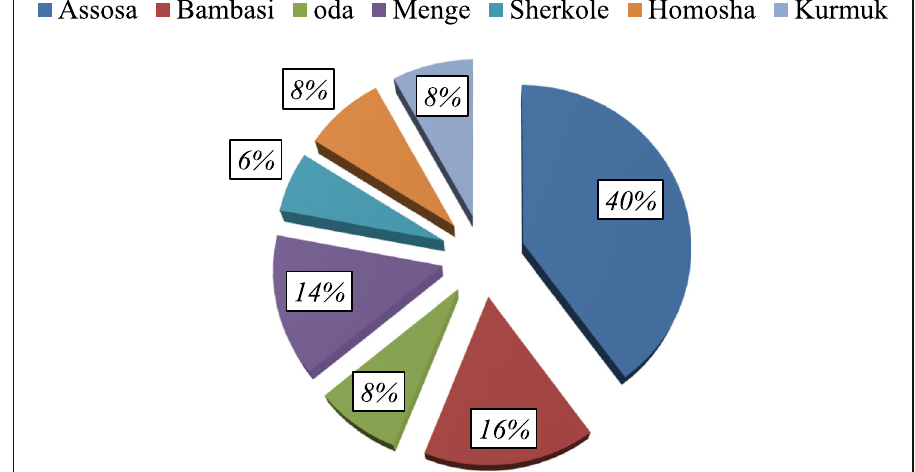
Fig. 3 Operational location of enterprises. Source: author ’ s computation based on firm survey